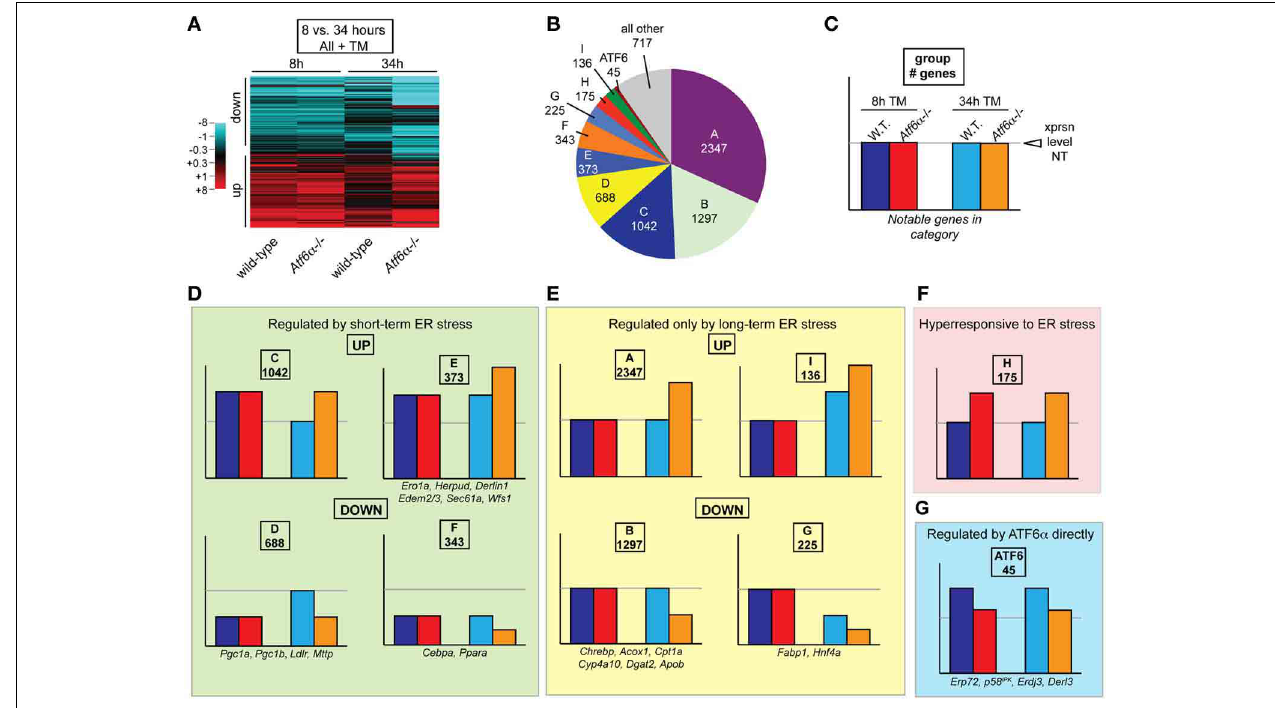
FIGURE 4 | Clustering of genes according to temporal regulation in wild-typeand Atf 6 α − / − animals.(A) Theexpressionofeveryprobesetonthe Affymetrix microarray described in Figure 3 was aggregated with expression data from a previously published identical array comparing gene expression in wild-type and Atf 6 α − / − animals 8h after challenge with vehicle or 2mg/kg TM (Rutkowski etal.,2008). Foreach timepoint, expression wasdetermined using alog 2 scalerelativetovehicle-treatedwild-typeanimalsatthattimepoint.Only probesets showing significant ( p < 0 . 05) expression differences (1.5-fold, or ± 0.58 on the log 2 scale) in one or more of the four of the four conditions (wild-typeor Atf 6 α − / − at8or34h)areshownbyheatmap,whichaccountedfor ∼ 7000 of the ∼ 45,000 probesets on the array. Extent of up- or downregulation is shown by intensity of red or blue coloration, respectively. Each column depicts expression level averaged among the three animals per group. (B,C) Everyprobesetonthearraywascharacterizedbyitsexpressioninthefollowing four ways, with differences defined as > 1.5-fold, p < 0 . 05: (1) up, down, or